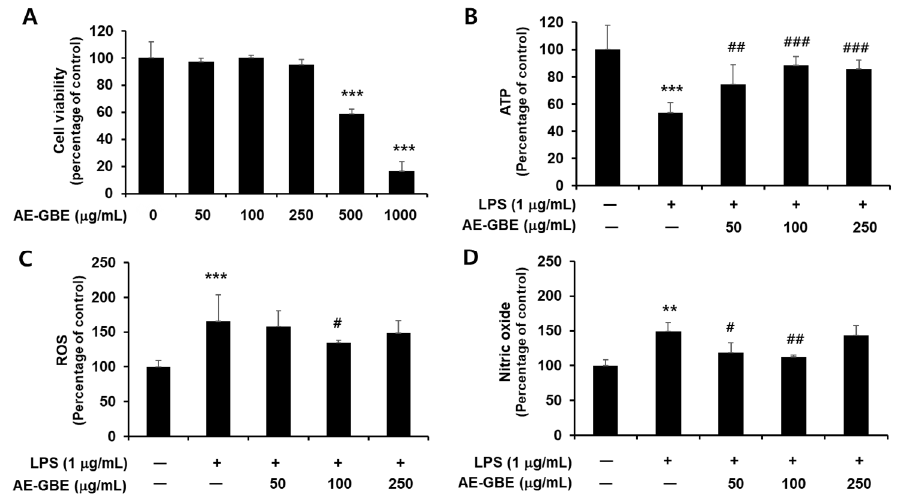
Figure 1. Cytotoxicity of AE-GBE and cytoprotective effect through inhibition of nitrite and ROS in LPS-induced Caco-2 cells. ( A ) Cytotoxicity to dose response of AE-GBE using MTT assay. ( B ) Dose-specific cytoprotective effect of AE-GBE on LPS-induced cell viability using ATP assay. ( C ) Dose-effects of AE-GBE on LPS–induced ROS production in cells. ( D ) Dose-effects of AE-GBE on nitric oxide (NO) level in LPS–treated cells. Values are expressed as percentage of negative control (CON). Results are shown as mean ± SD ( n = 3–5). **: p < 0.01 and ***: p < 0.001 versus negative control. #: p < 0.05, ##: p < 0.01, and ###: p < 0.001 versus LPS treated only.